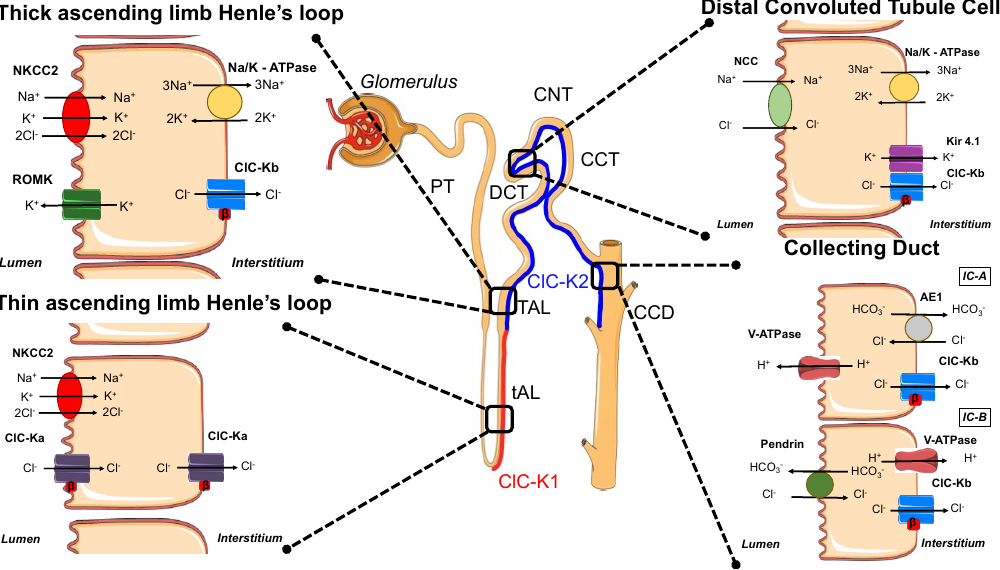
Figure 1. Overview of ClC-K chloride channels’ distribution at distinct nephron sites. Pattern of expression of rat orthologues: ClC-K1 (red line) in the thin ascending limb (tAL) and ClC-K2 (blue line) in thick ascending limb (TAL) through distal convoluted tubule (DCT) and in intercalated cells (IC-A and IC-B) of collecting duct (CD). ClC-Ka (dark violet) mainly expressed in tAL in both apical and basolateral membrane. ClC-Kb (blue) expression in the basolateral membrane along the neph- ron participating in Cl - reabsorption. Both isoforms are represented with their accessory subunit β bar tt in (red). Loss of function of chloride channels causes Bar tt er Syndrome type III. NKCC2, Na + K + 2Cl − cotransporter; ROMK, renal outer medullary potassium channel. Table 1. Localization and physiological role of ClC-K channels in the kidney and inner ear as as- sessed from animal models.